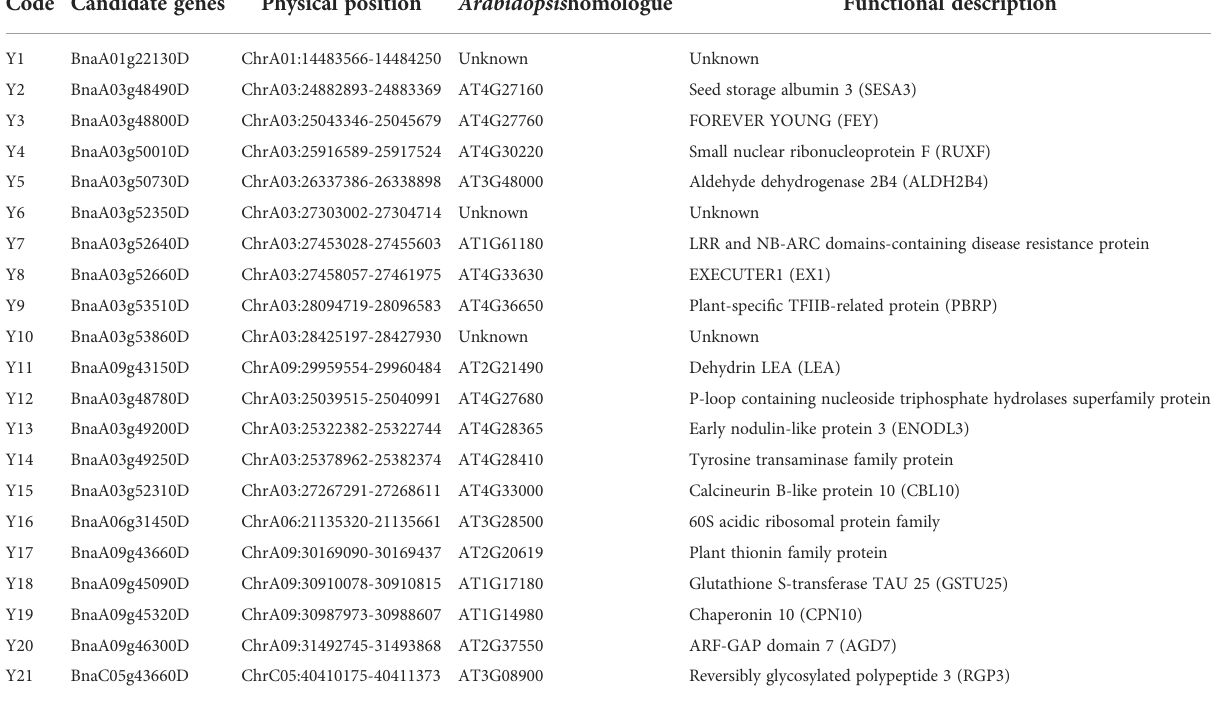
TABLE 4 Identi fi cation of candidate genes by combining QTL mapping with